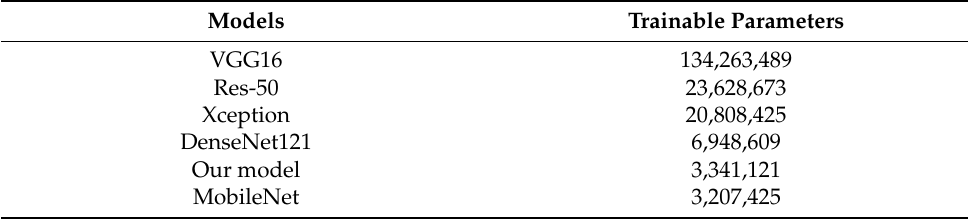
Table 1. Trainable